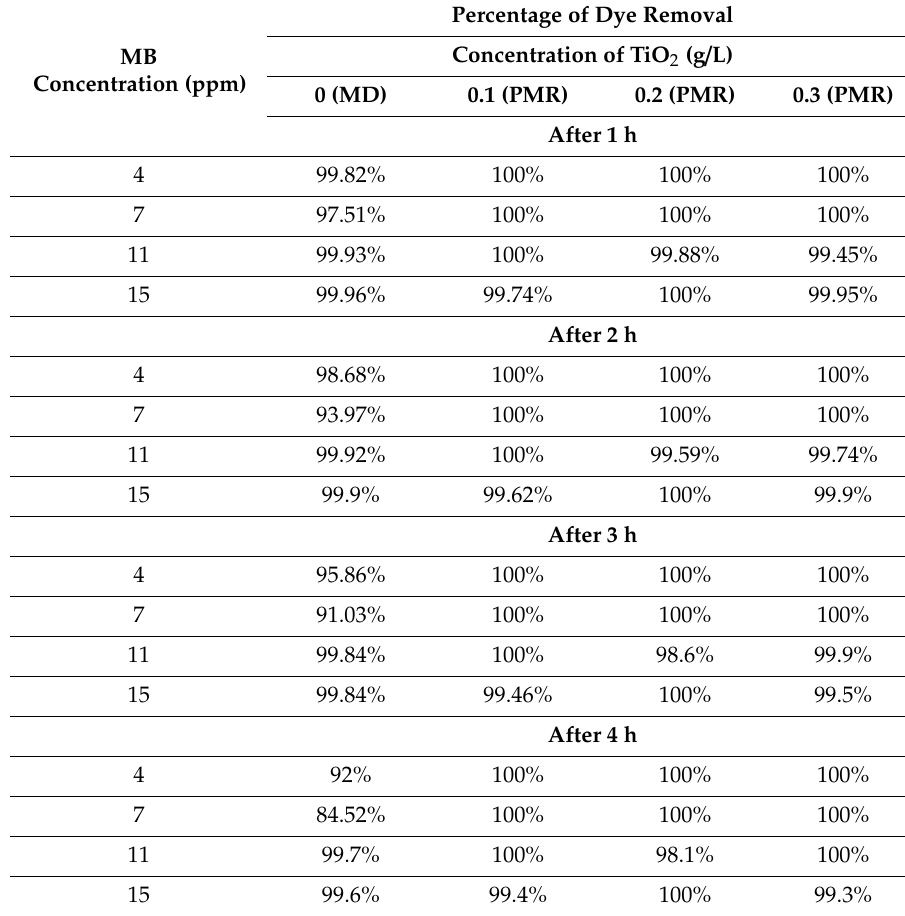
Table 3. Summary—PMR and membrane distillation (MD) performance.